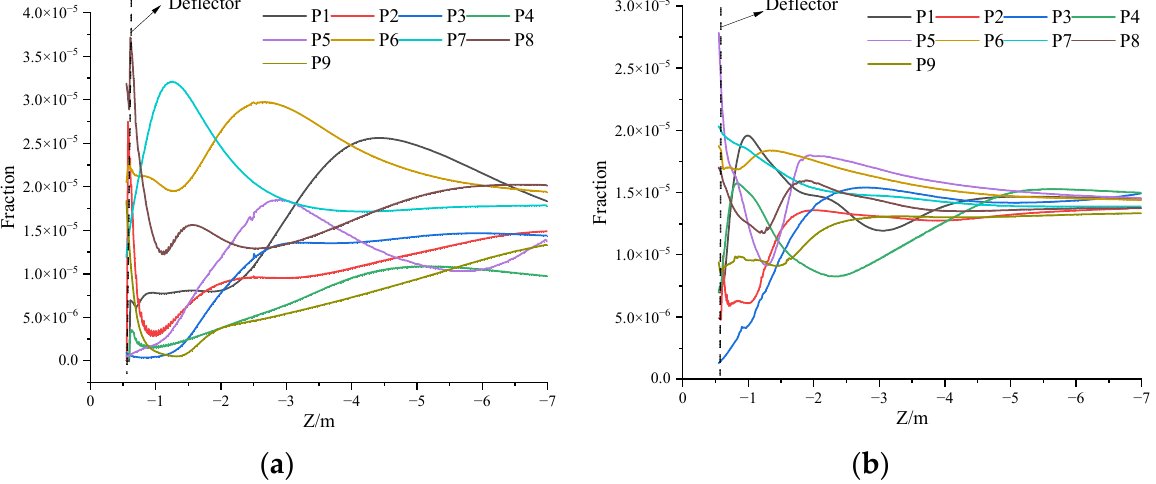
Figure 8. Flocculant concentration change at different positions of the outlet pipe: ( a ) before optimization; ( b ) after optimization.